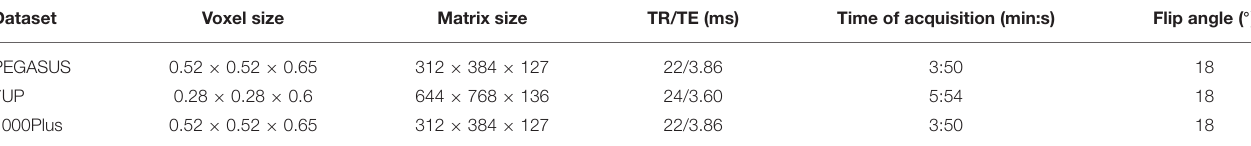
TABLE 1 | Time of flight (TOF) magnetic resonance imaging (MRI) parameters.